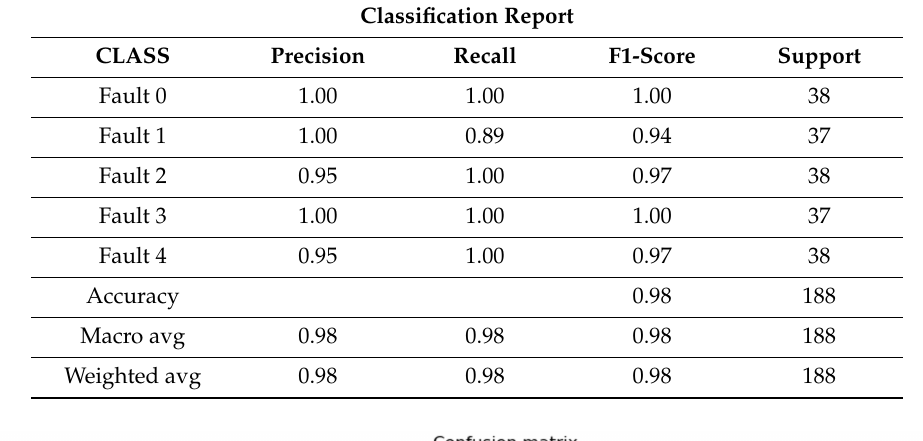
Table 4. Classification report on the test dataset.